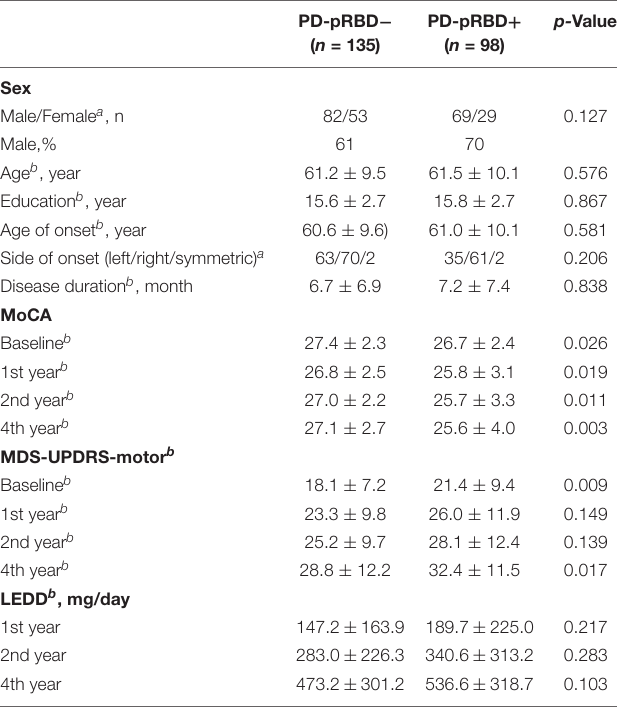
TABLE 1 | Demographic and clinical characteristics.